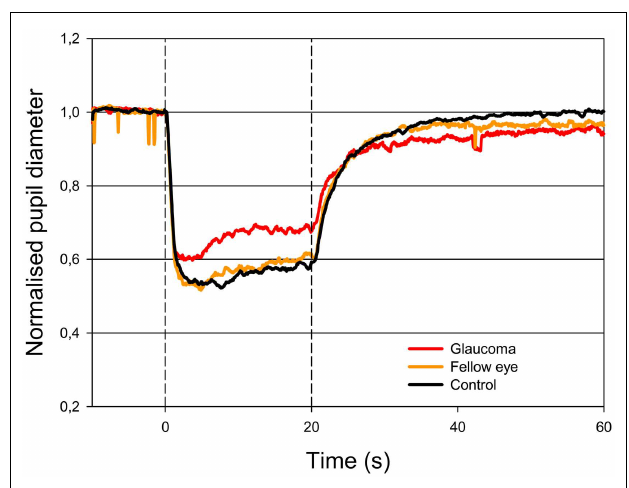
FIGURE 1 | Pupillary contraction to a red light stimulus (660nm) as a function of time (s) . A constant and continuous stimulus of 300cd/m 2 was applied at time 0 (first vertical dashed line) and discontinued at the end of the 20th second (second vertical dashed line).The stimulus was applied to one eye and the consensual, pupillary contraction of the other eye recorded.The red graph represents the mean of contractions set off by stimulation in glaucomatous eyes, the yellow, the mean of contractions set off by stimulation in unafflicted fellow eyes and the black the mean of contractions set off by stimulation in control eyes. During light stimulation, contraction is larger in the yellow graph than in the red graph.When the light stimulus is terminated, fairly rapid dilatation ensues and no statistically significant difference is detected (cf. Table 2 ). Colored graphs represent mean values from 11 subjects suffering from unilateral glaucoma, the black graph the mean from 11 healthy control eyes.The AUC is the area between the horizontal line: NPD = 1.0 and the graph in